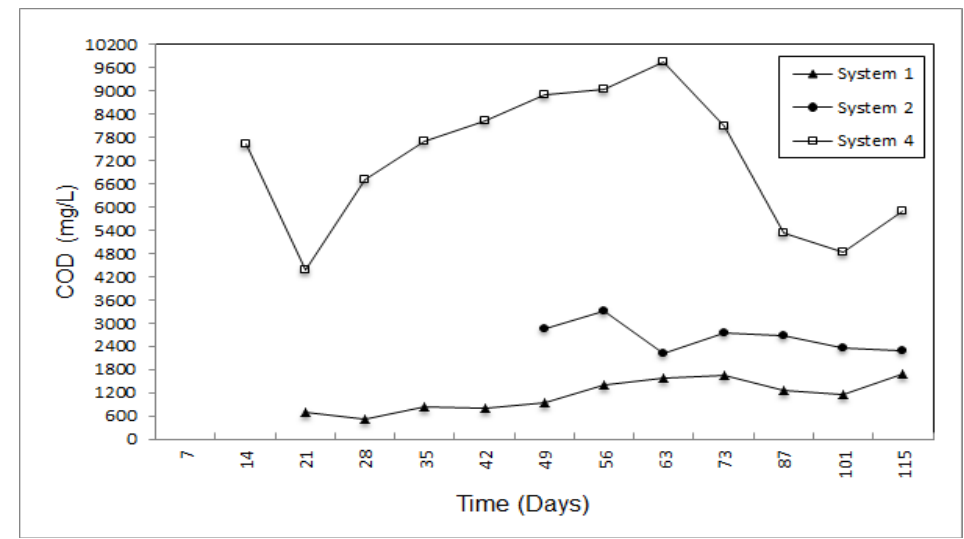
Figure 8. COD concentration of